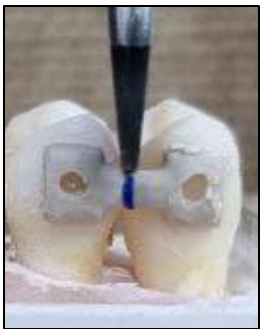
Figure 1: Bond strength test of PEEK retainer.